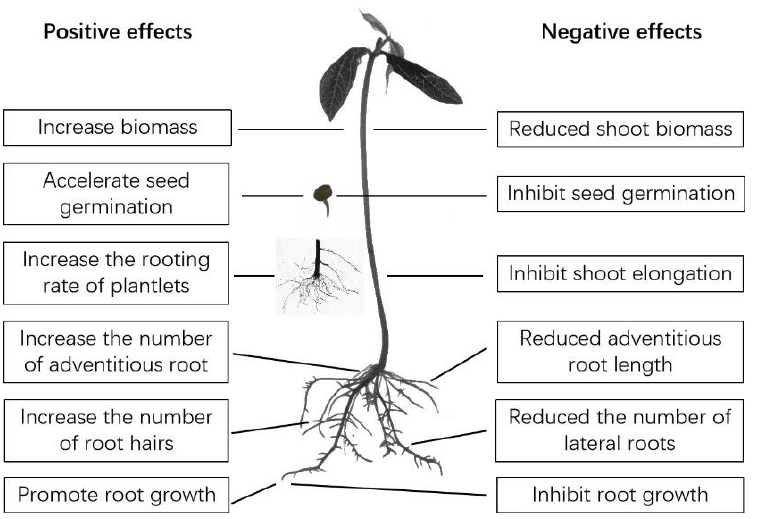
Figure 1. Diagram summarizing the effects of graphene-family nanomaterials (GFNs) on plant growth.